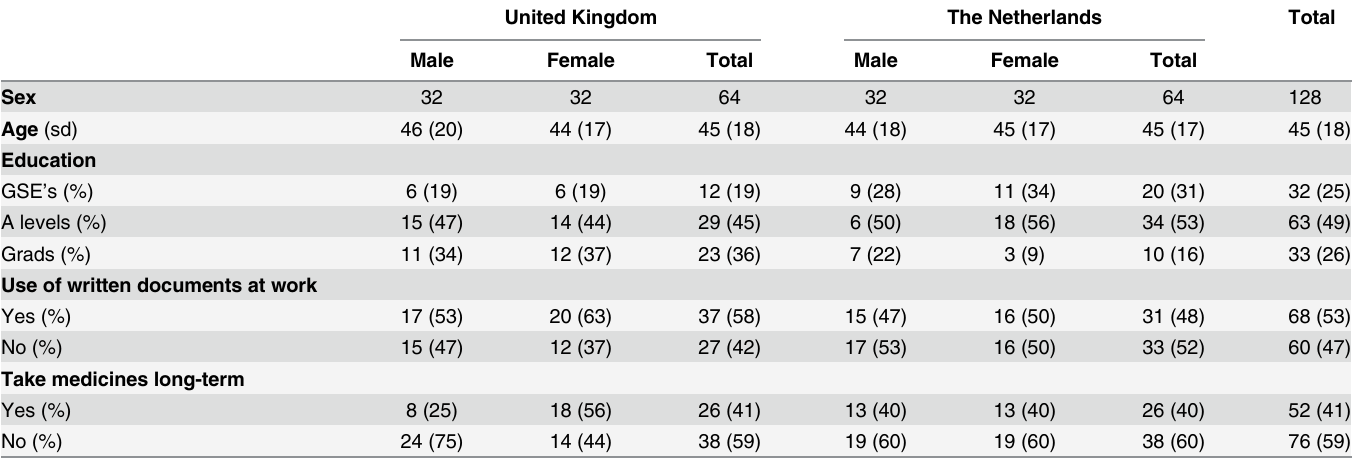
Table 5. Participant characteristics in the UK and NL